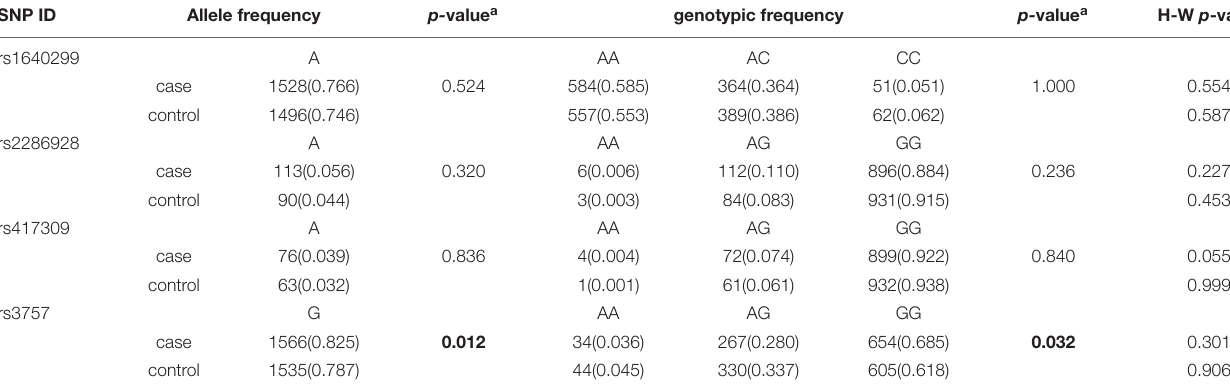
TABLE 1 | The distribution of alleles and genotypes for the four SNPs in DGCR8 3 (cid:48) UTR.